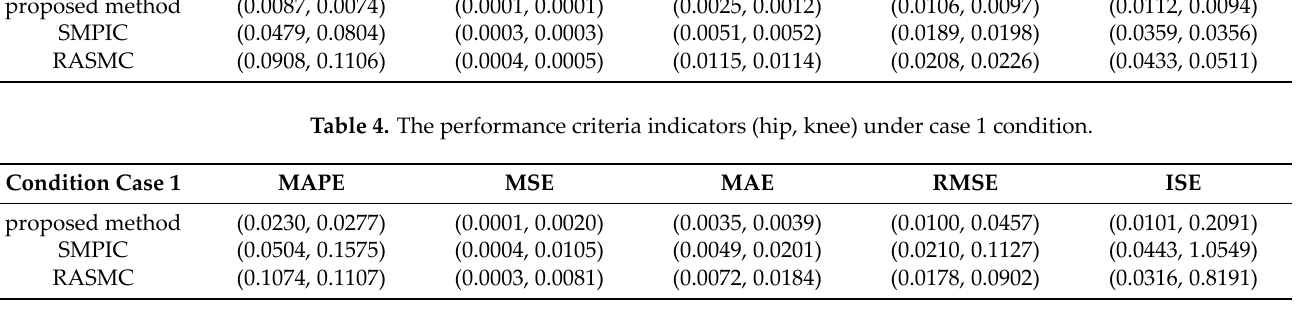
Table 3. The performance criteria indicators (hip, knee) under case 0 condition.